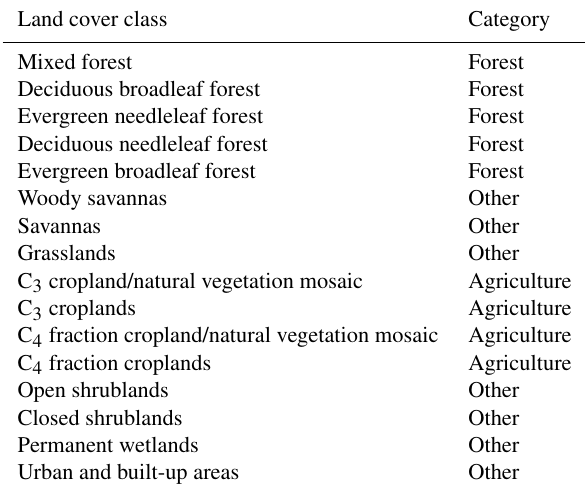
Table 1. Grouping of the different ecosystems in the categories for- est, agriculture, and